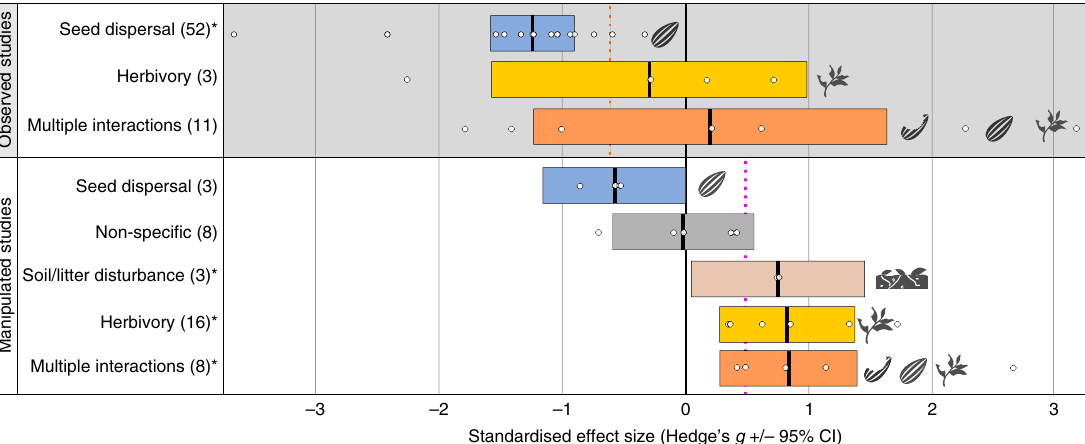
Fig. 3 Effect sizes of defaunation on forest regeneration by woody vegetation-animal interaction type. Observed and manipulated studies are analysed separately. The number of pairwise comparisons between high fauna and low fauna treatments per category is reported in parentheses, mean standardised effect size (Hedges ’ g ) is indicated by the bold vertical line in the centre of the coloured box, and 95% con fi dence intervals are represented by the width of the coloured box. Asterisks (*) denote categories where the con fi dence intervals do not overlap zero, indicating a signi fi cant effect (Hedges ’ g ). Please note that the fi gure shows the impact related to the absence of each woody vegetation-animal interaction type; a negative effect size means that defaunation is having a detrimental impact on forest regeneration. Vertical dashed lines show the mean overall effect size for observed ( − 0.68) and manipulated ( + 0.45) studies, respectively